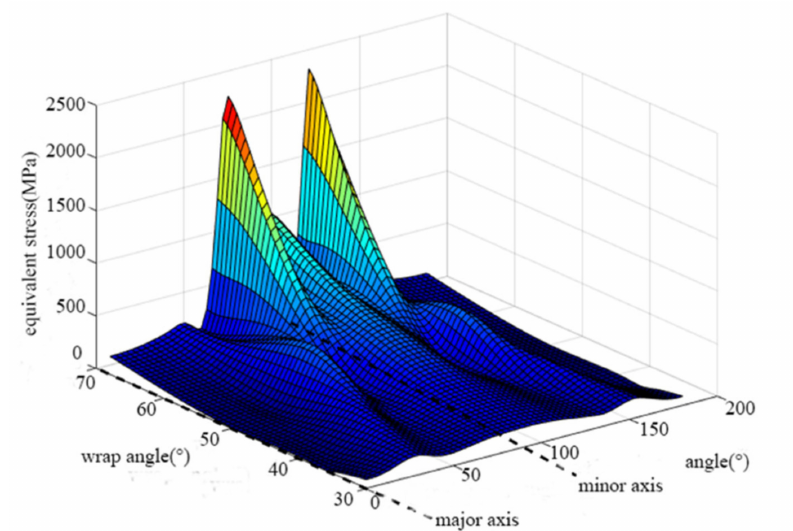
Figure 6. Equivalent stress of flexspline in double eccentric arc cam with different wrap angle.